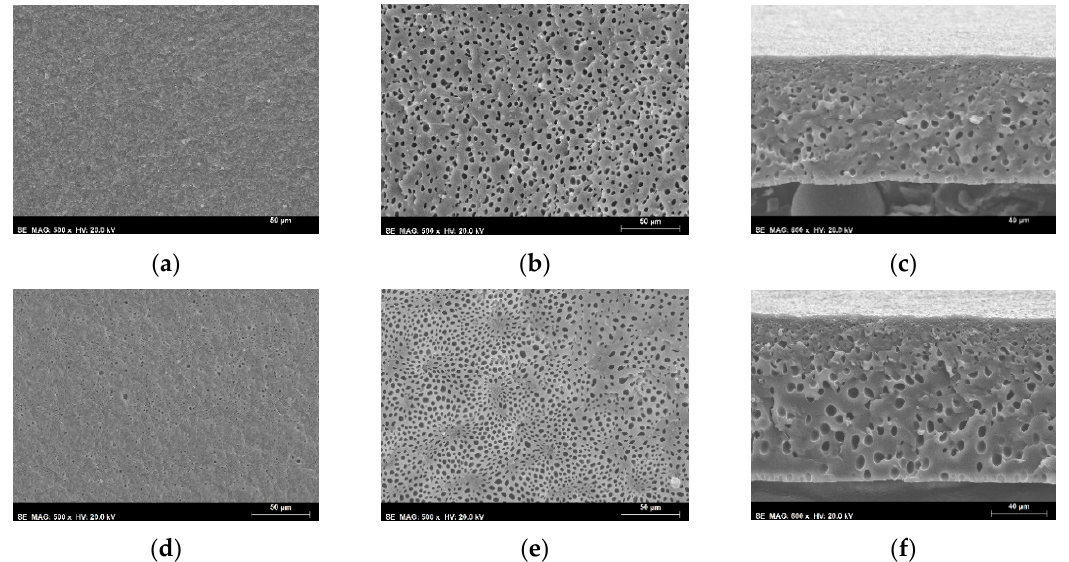
Figure A3. SEM images of the integral asymmetric PU10-5 and PU10-10 membranes: ( a ) top surface of PU10-5, ( b ) bottom surface of PU10-5, ( c ) cross-section of the of PU10-5; ( d ) top surface of PU10-10, ( e ) bottom surface of PU10-10, ( f ) cross-section of PU10-10.